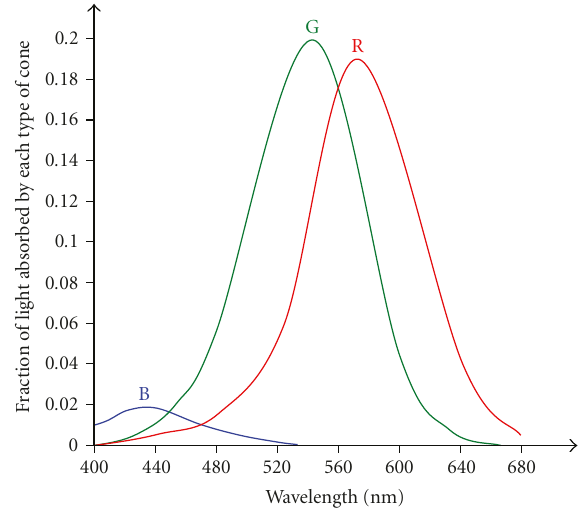
Figure 2: Sensitivity of the